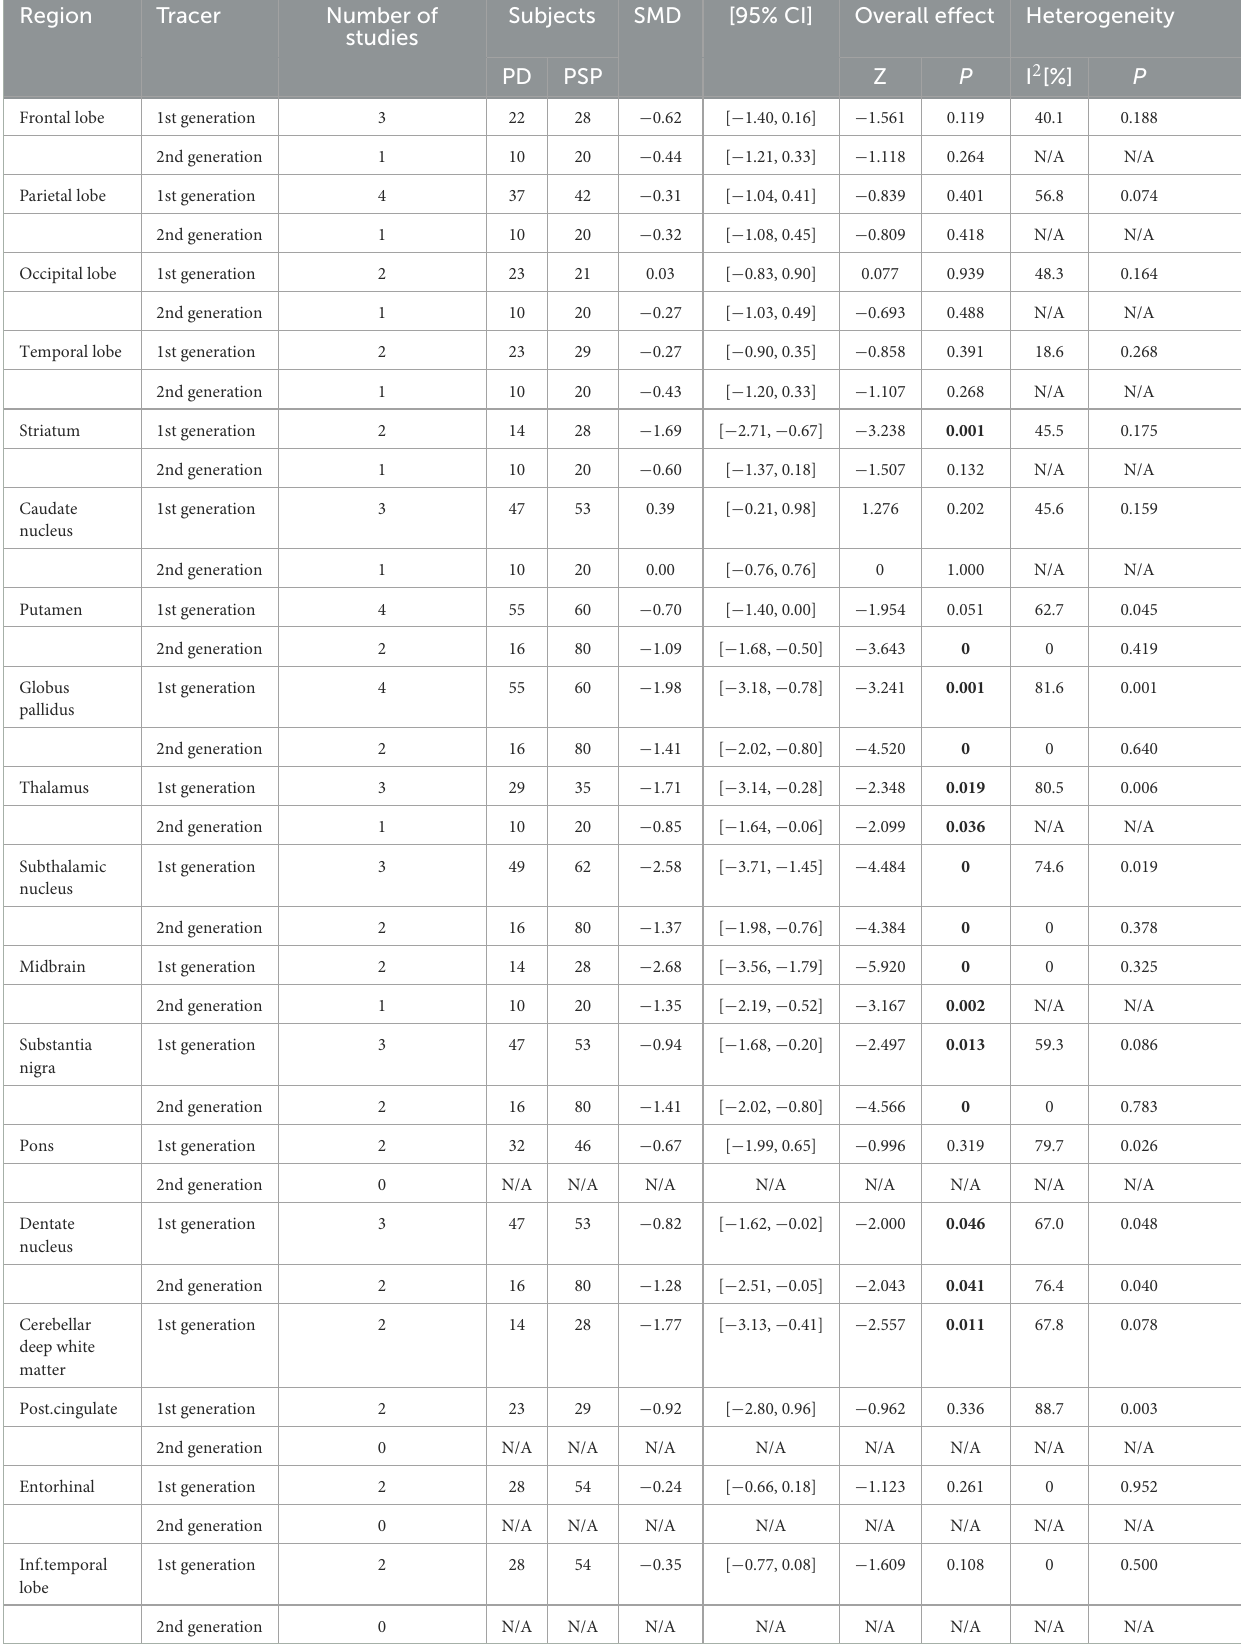
TABLE 7 Subgroup analysis based on the type of tau tracer used for studies involving PSP and PD subjects. Region Tracer Number of Subjects SMD [95% CI] Overall effect Heterogeneity studies